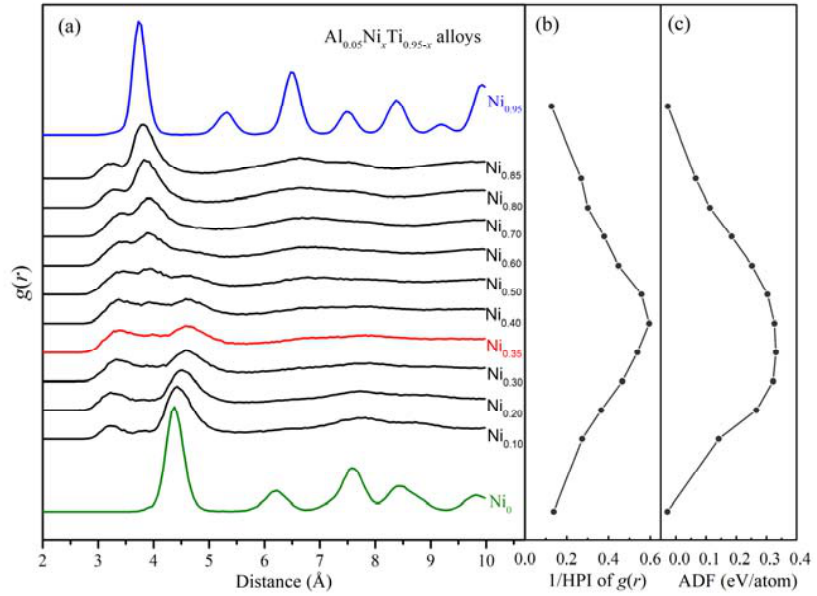
Figure 5. ( a ) Pair-correlation function ( g (r)). ( b ) The reciprocal of the highest-peak’s intensity (HPI) of g (r). ( c ) The amorphous driving force (ADF) of the Al0.05NixTi0.95-x alloys obtained by MD simulations.